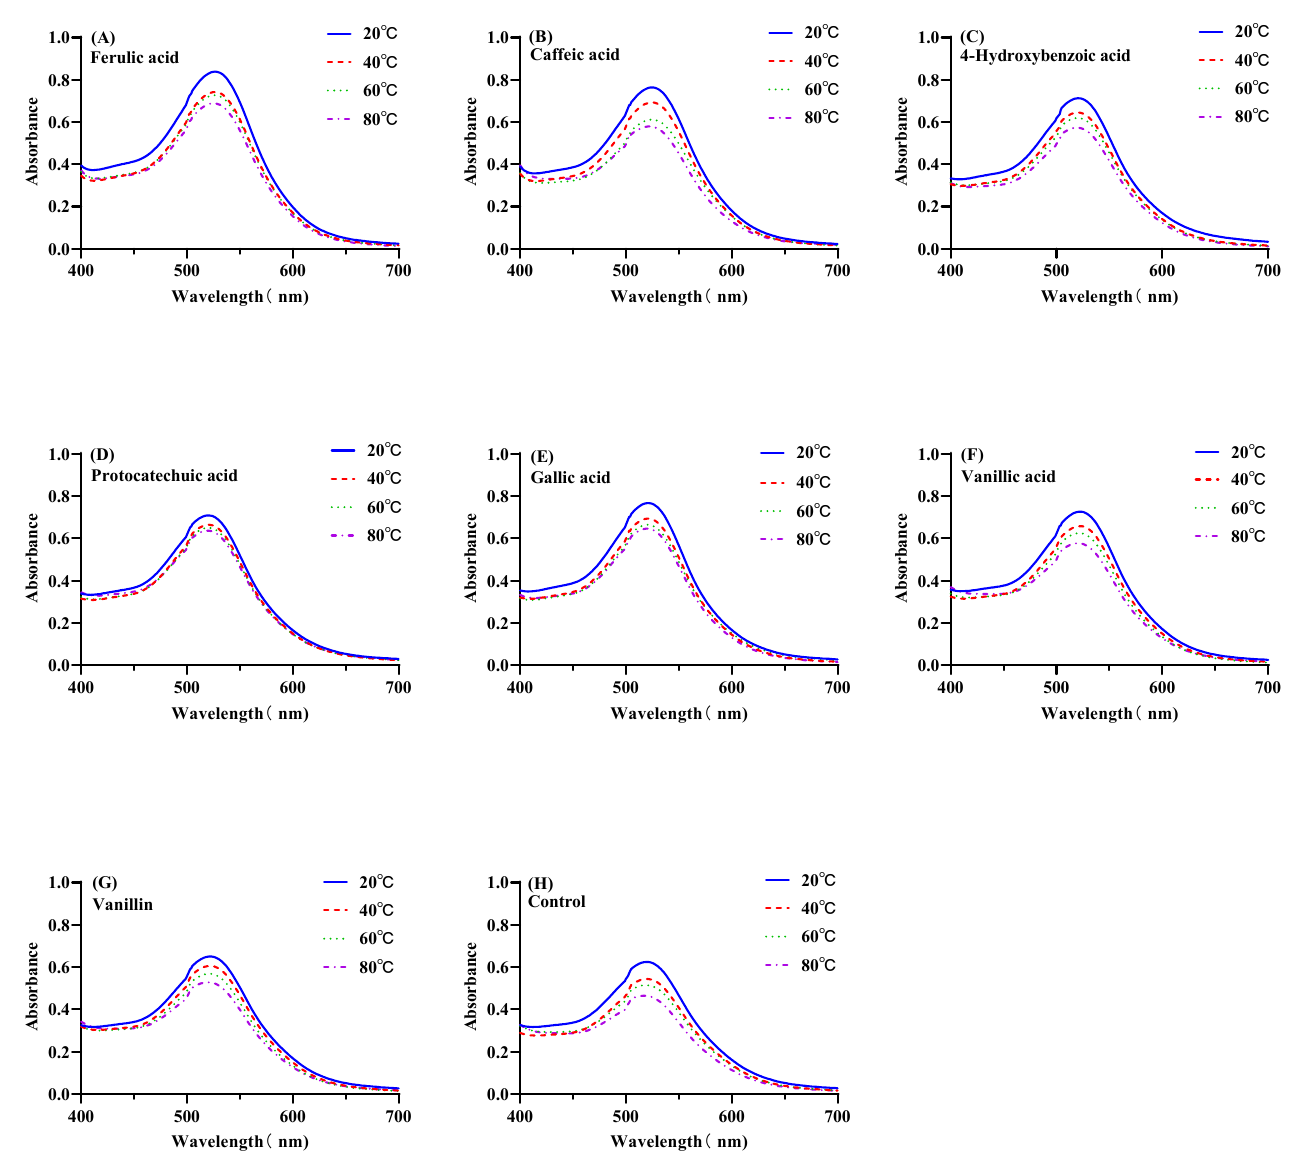
Figure 5. Visible absorption spectra of the mulberry anthocyanin co-pigmentation with co-pigments (1:20, pH = 3.5) at different temperatures (( A ): FA; ( B ): CA; ( C ): HBA; ( D ): PA; ( E ): GA; ( F ): VA; ( G ): VN; ( H ): control).